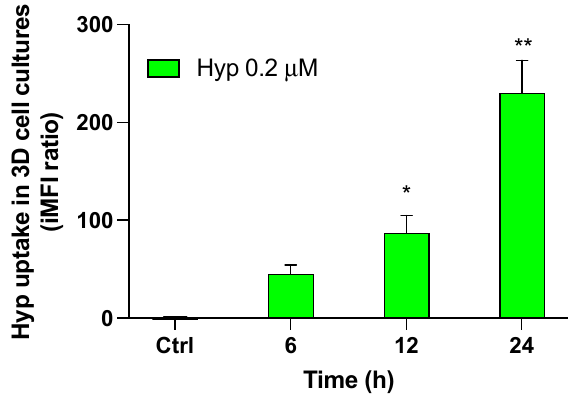
Figure 10. Hypericin uptake in 3D HT-29 cell cultures. HT-29 spheroids were incubated for 24 h with 0.2 µ M Hyp. Fluorescent signals were detected using a flow cytometer at 488 nm excitation to measure the intracellular amount of Hyp, which was expressed as iMFI ratio. Statistically significant difference versus untreated cells (Ctrl): * p ≤ 0.05, ** p ≤ 0.01 ( n = 3).